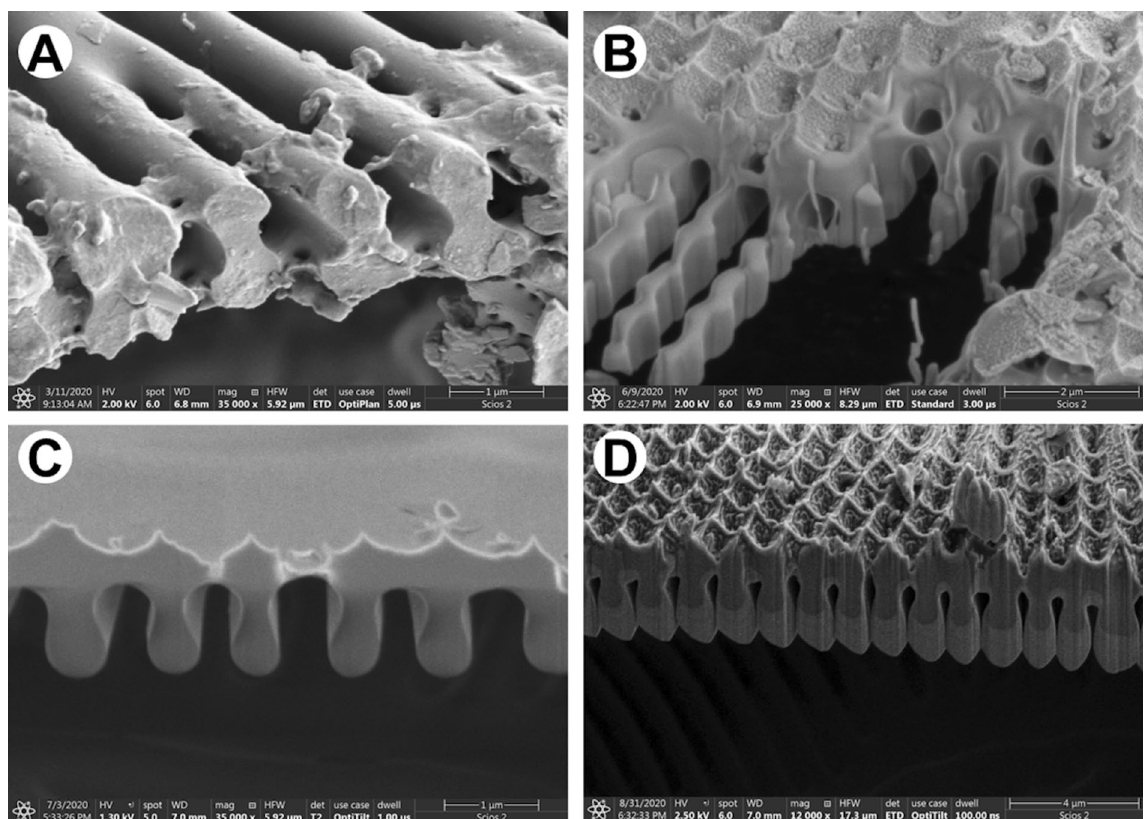
Figure 5. SEM images of cross-section of D. geminata valve: ( A ) naturally broken shell; ( B–D ) after FIB